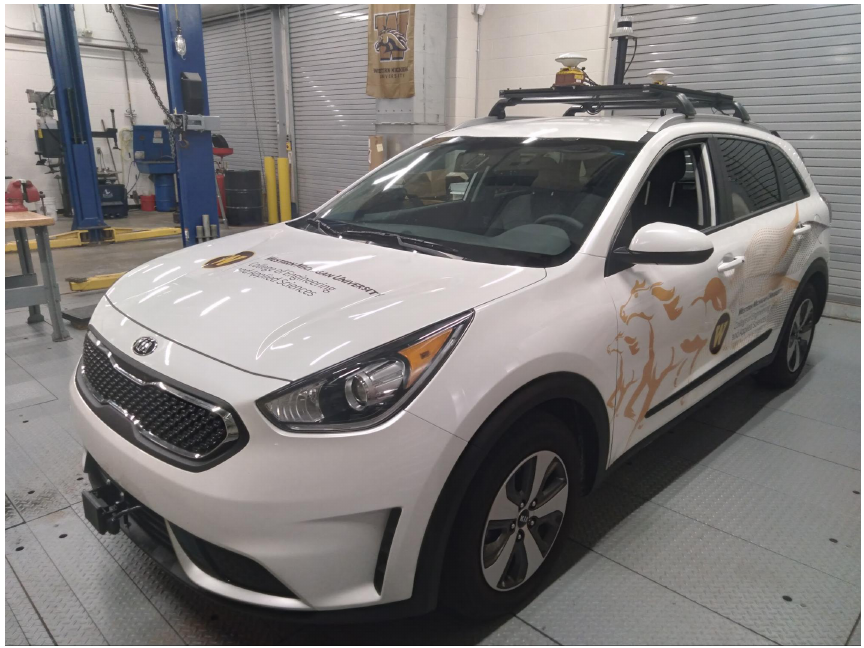
Figure 23. Instrumentation complete for 2019 Kia